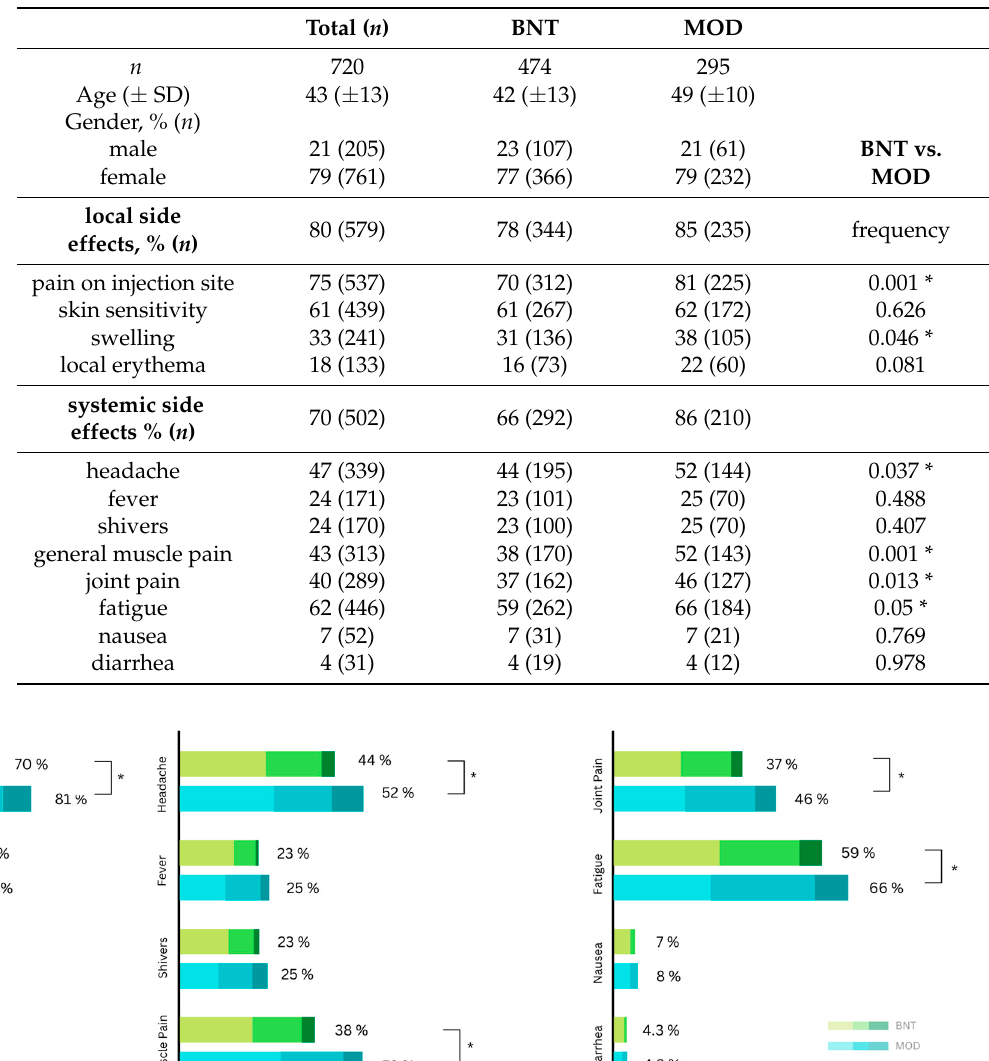
Table 5. Acute local and systemic side effects after the third (booster) vaccination. Asterisks indicate statistical significance. (BNT: Biontech/Pfizer (BNT162b2); MOD: Moderna (mRNA-1273)). p -values indicate the significance level of the difference in frequency.